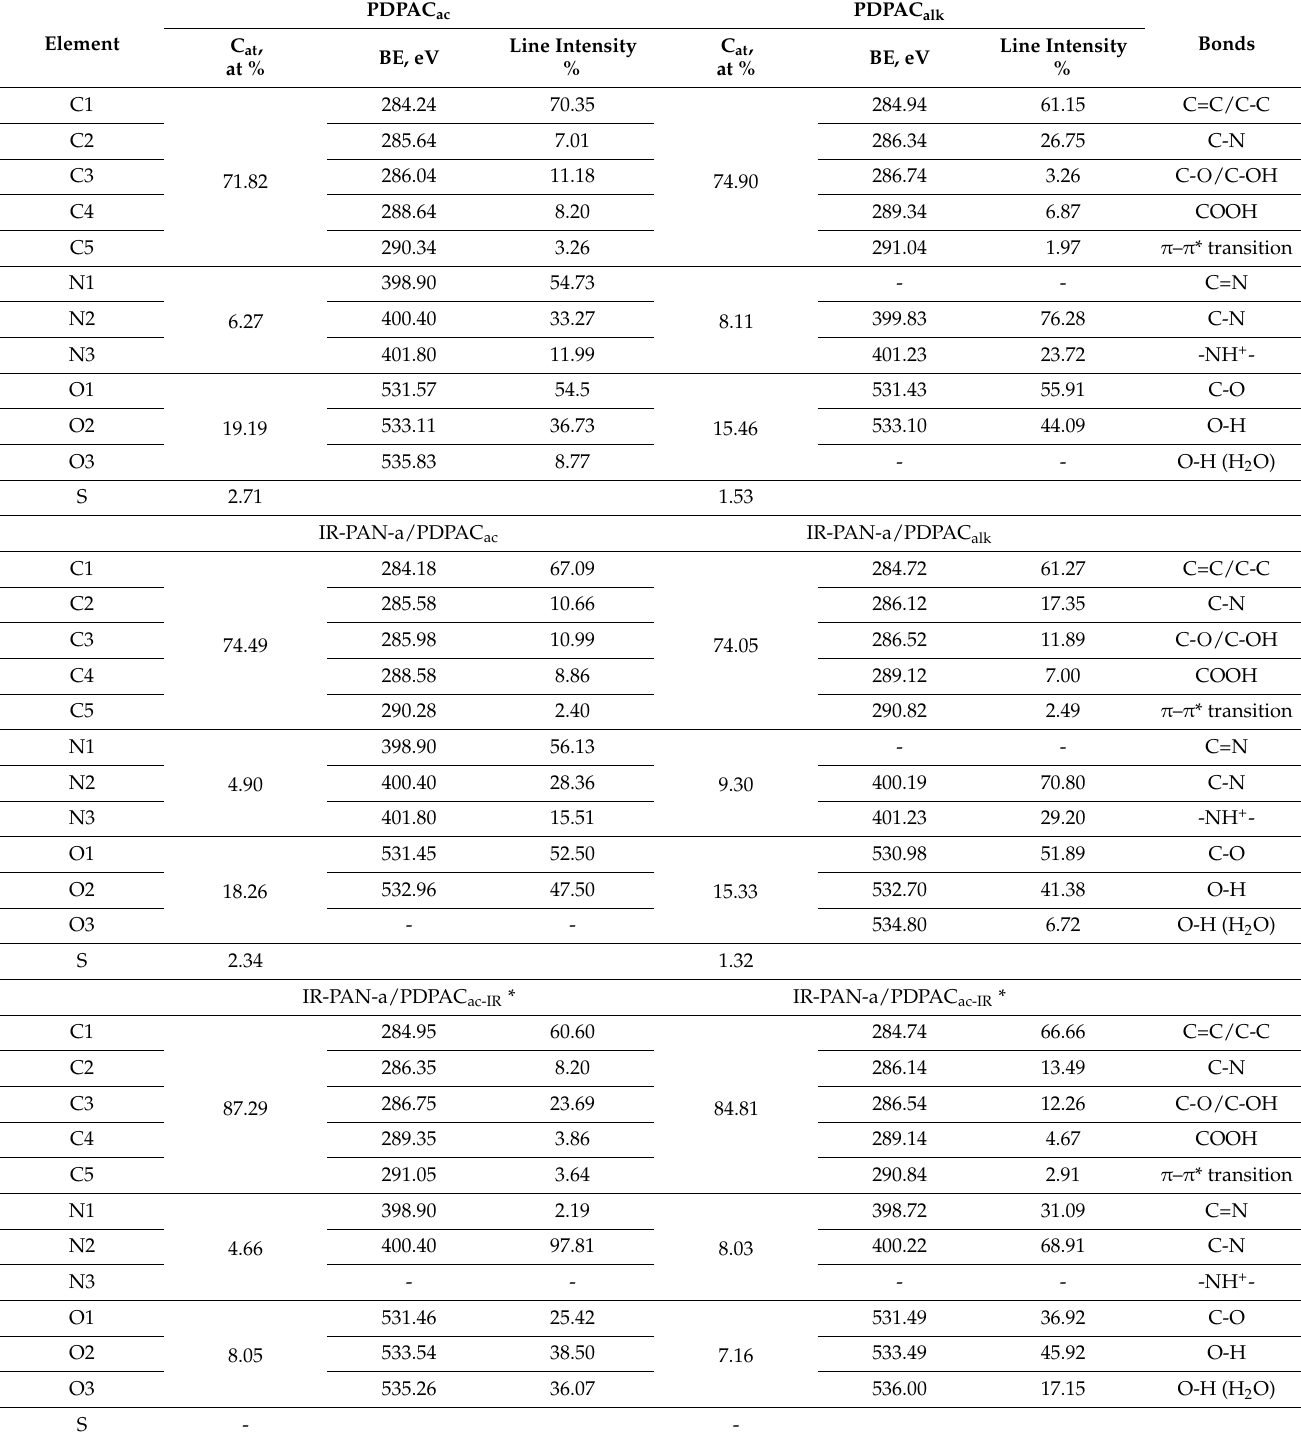
Table 1. XPS study of